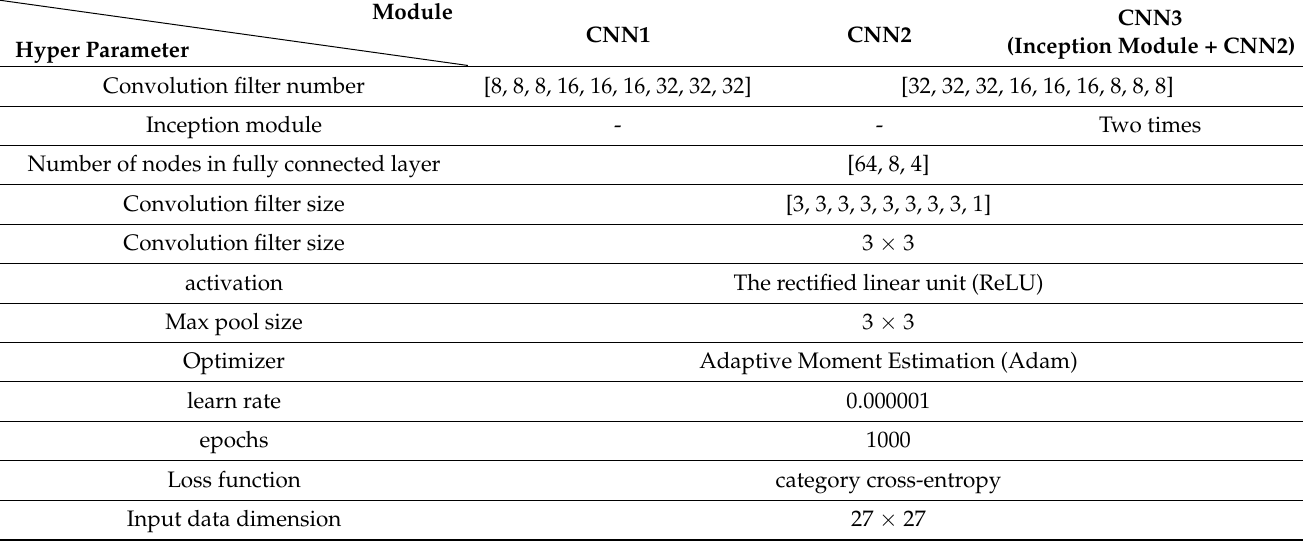
Table 4. Hyperparameters used for CNN-1, CNN-2, and CNN-3